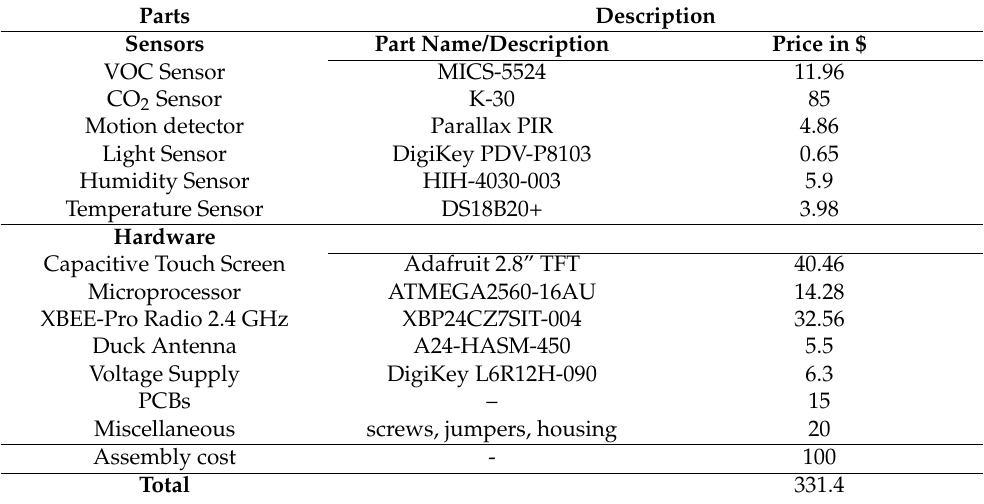
Table 1. Cost of PCFN (production